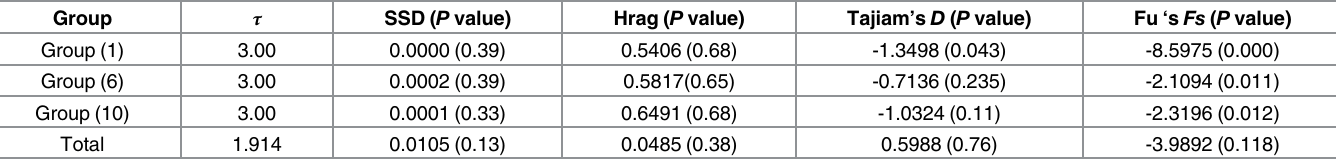
Table 3. Results of neutrality tests and mismatch distribution analysis for Ephedra przewalskii